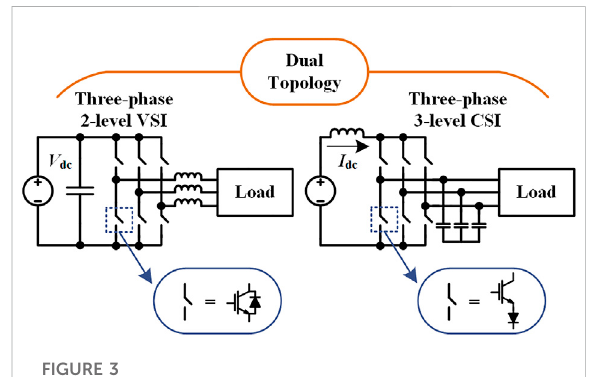
FIGURE 5 Graphs of DNPC phase module and its duality